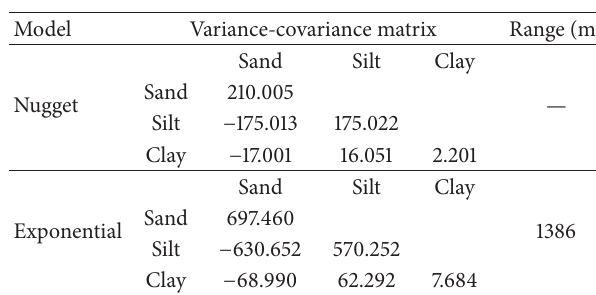
Table 3: Parameters for the fitted linear model of coregionalization for original three components.